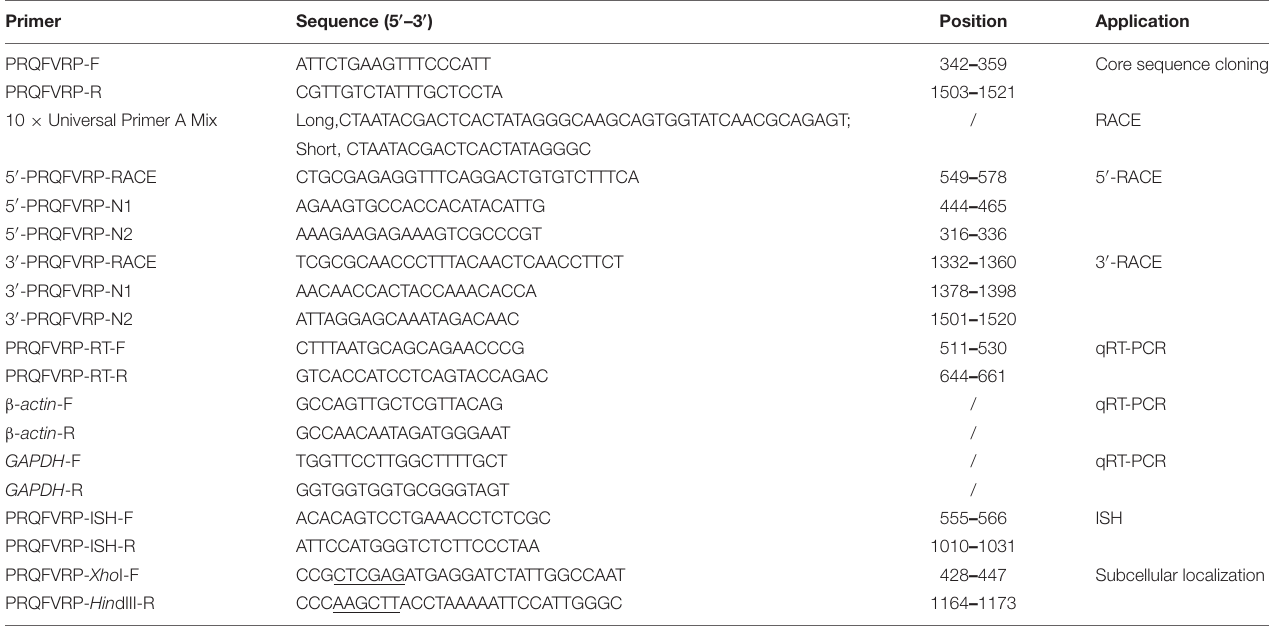
TABLE 1 | Primers used in this